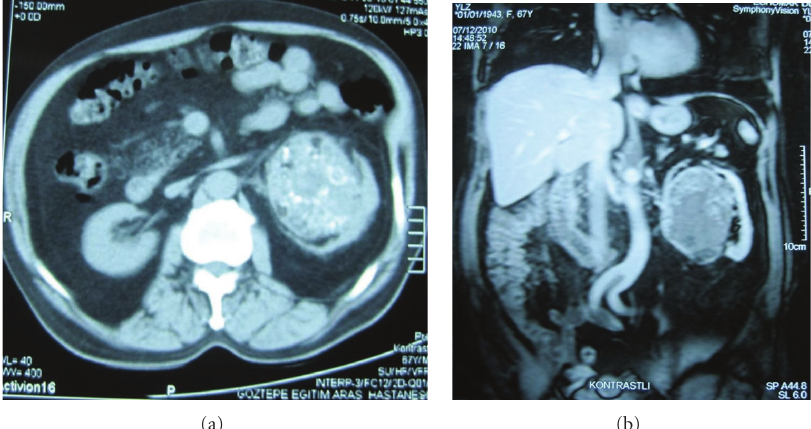
Figure 1: (a) Unenhanced CT scan of left kidney, showing areas of calcifications corresponding to metaplastic bone. (b) Coronal imaging of MR reveal a well-defined, solid tumor of left kidney with heterogenous enhancement.